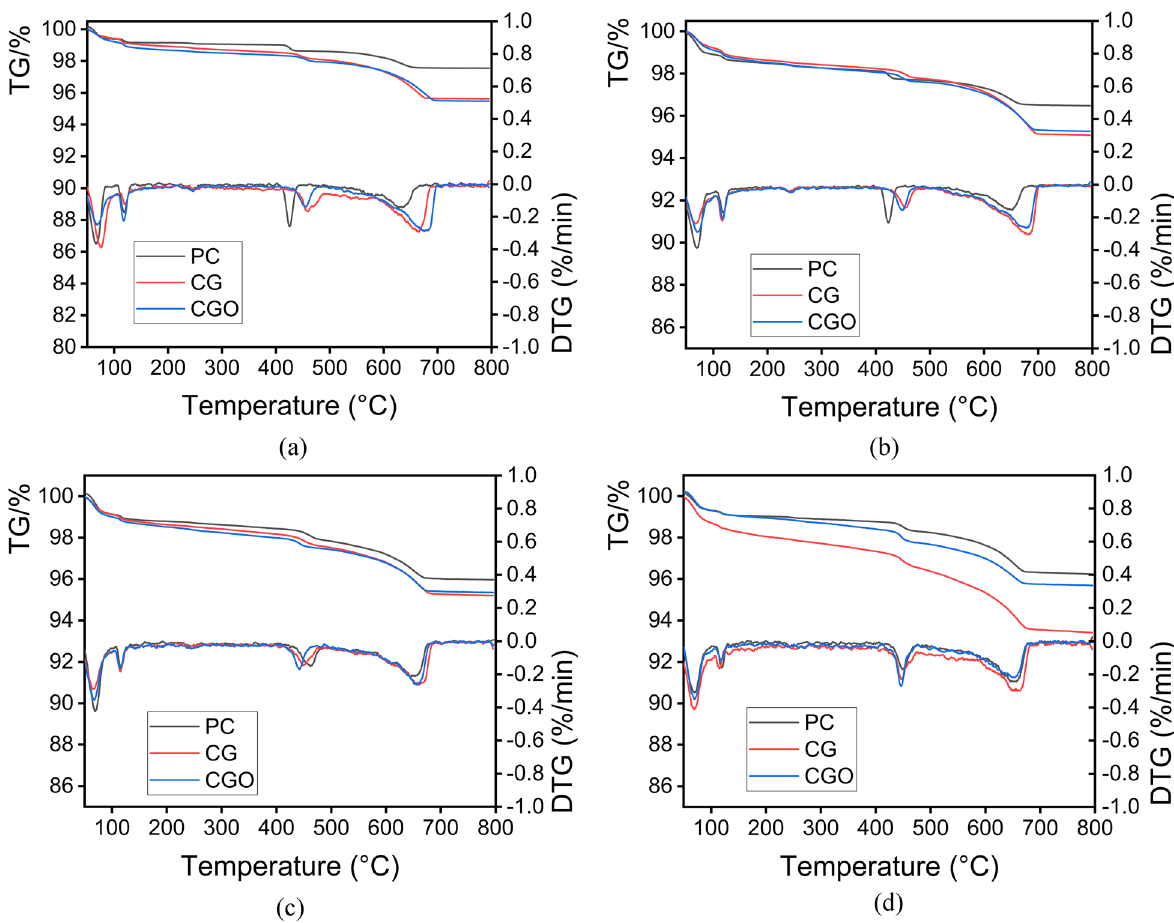
Figure 6: TG - DTG analyses of PC, CG, and CGO pastes at 15 min ( a ) , 1 h ( b ) , 4 h ( c ) , and 7 h ( d )